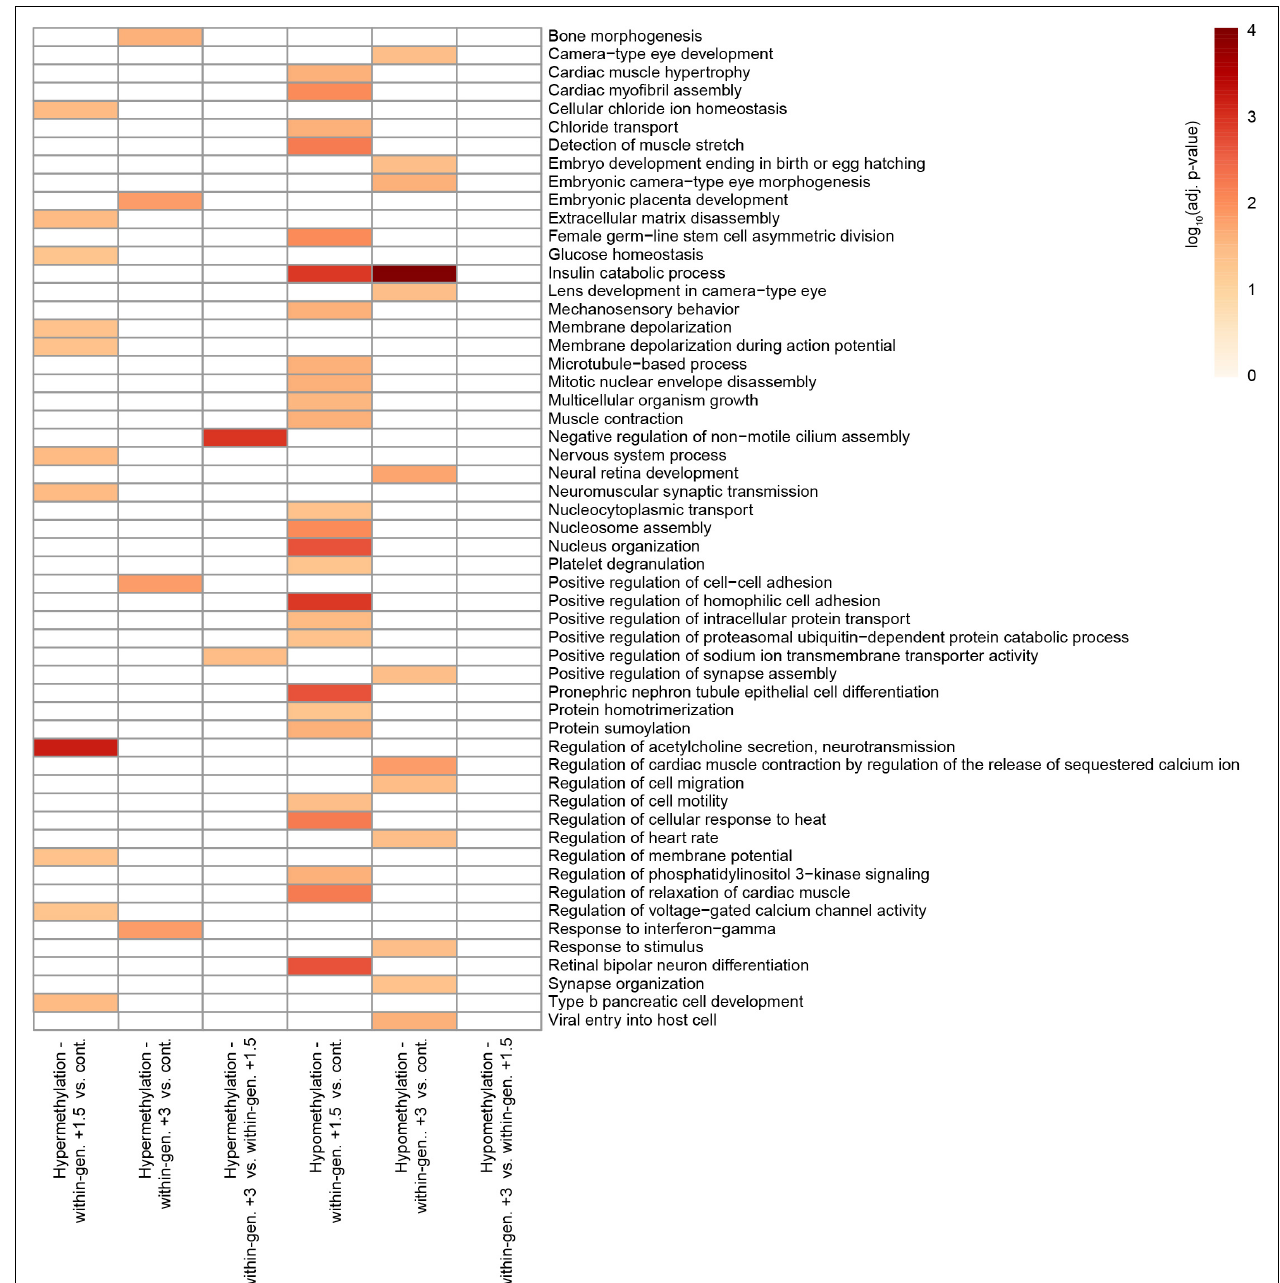
FIGURE 3 | Gene Ontology enrichment of DMR genes related to within-generational plasticity. Significantly enriched GO terms (adjusted p < 0.05) between two experimental groups are listed on the right side of the heatmap. Adjusted p -values are –log10 transformed and colored as indicated on the color key.